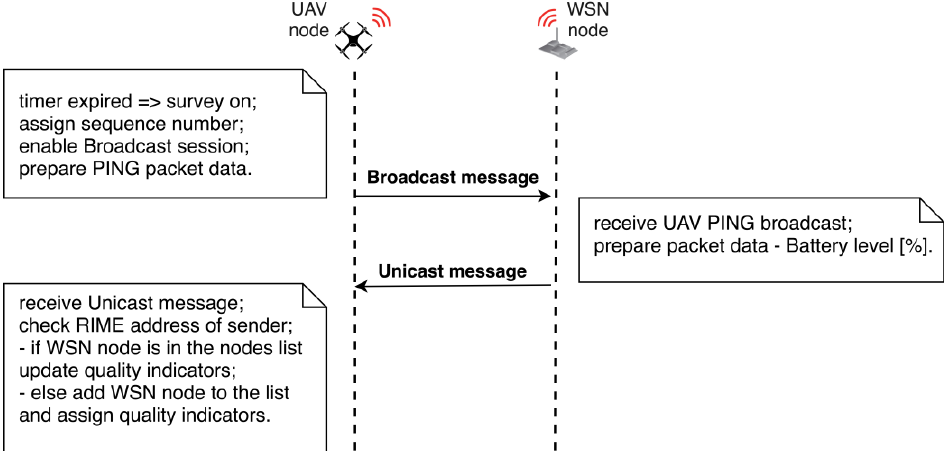
Figure 6. UAV-WSN survey dialog sequence.